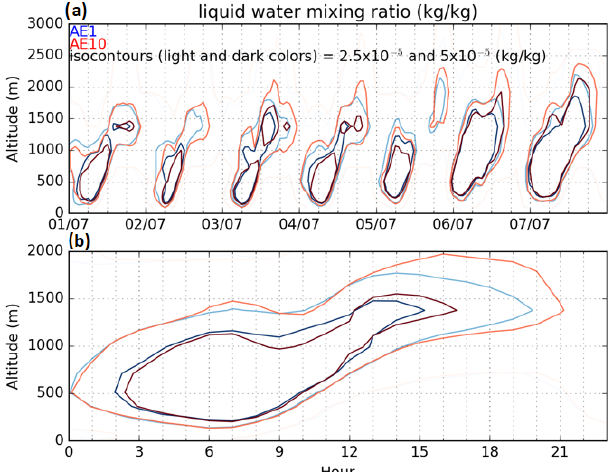
Figure 8. Time series (a) and diurnal cycles (b) of modeled hourly liquid water path (kgm − 2 ) for the two experiments, AE1 (blue) and AE10 (red), averaged over an inland area extending from 7 to 9 ◦ N, and from 1 to 4 ◦ E, and for the period 1–7 July 2016. (a) The vertical dashed lines indicate periods of 6h starting at 00:00UTC. (b) Means of each hour for the period 1–7 July 2016 are pre- sented by lines, and the upper and lower shading limits correspond to the hourly standard deviation. Daily averages of the Moder- ate Resolution Imaging Spectroradiometer (MODIS) data retrieved by the instruments on the Terra and the Aqua satellites (datasets: MCD06COSP-D3) are black dots with the error bars representing the standard deviation in the area.